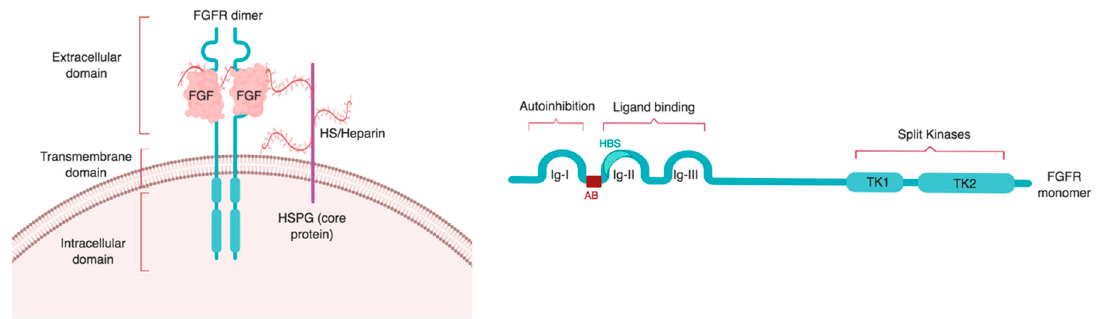
Figure 1. Domain structure of FGFRs: an extracellular domain containing ligand binding site is followed by a single transmembrane domain, and an intracellular domain containing split tyrosine kinases. Left panel: organization of the FGF–FGFR complex at the cell surface. The FGF–FGFR complex is stabilized by a heparin / HS chain of the HS proteoglycan (HSPG). Right panel: The extracellular domain of the receptor is composed of three Ig-like domains: Ig-I, Ig-II, and Ig-III. Ig-I has autoinhibitory capacity while Ig-II and Ig-III form the ligand binding domain. Ig-II contains the heparin / HS binding site (HBS) and is separated from Ig-I by an acid box (AB). The cytoplasmic domain is formed by two tyrosine kinases: tyrosine kinase 1 (TK1) and tyrosine kinase 2 (TK2). Image created with biorender.com.